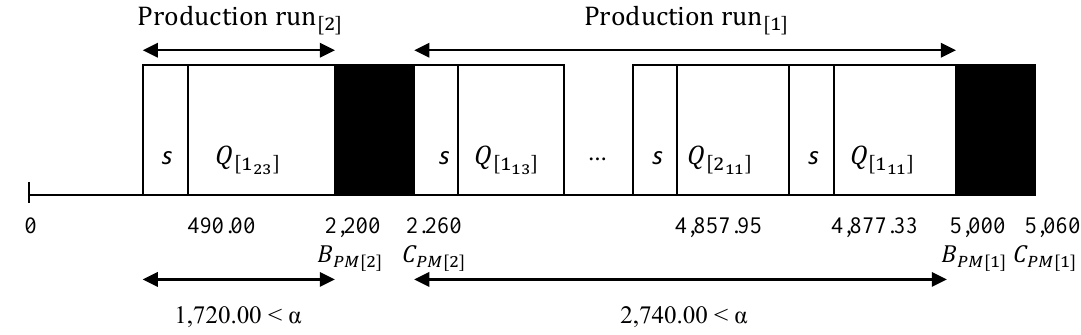
Fig. 8. Gantt-Chart of the solution of Algorithm [MISM] for the problem